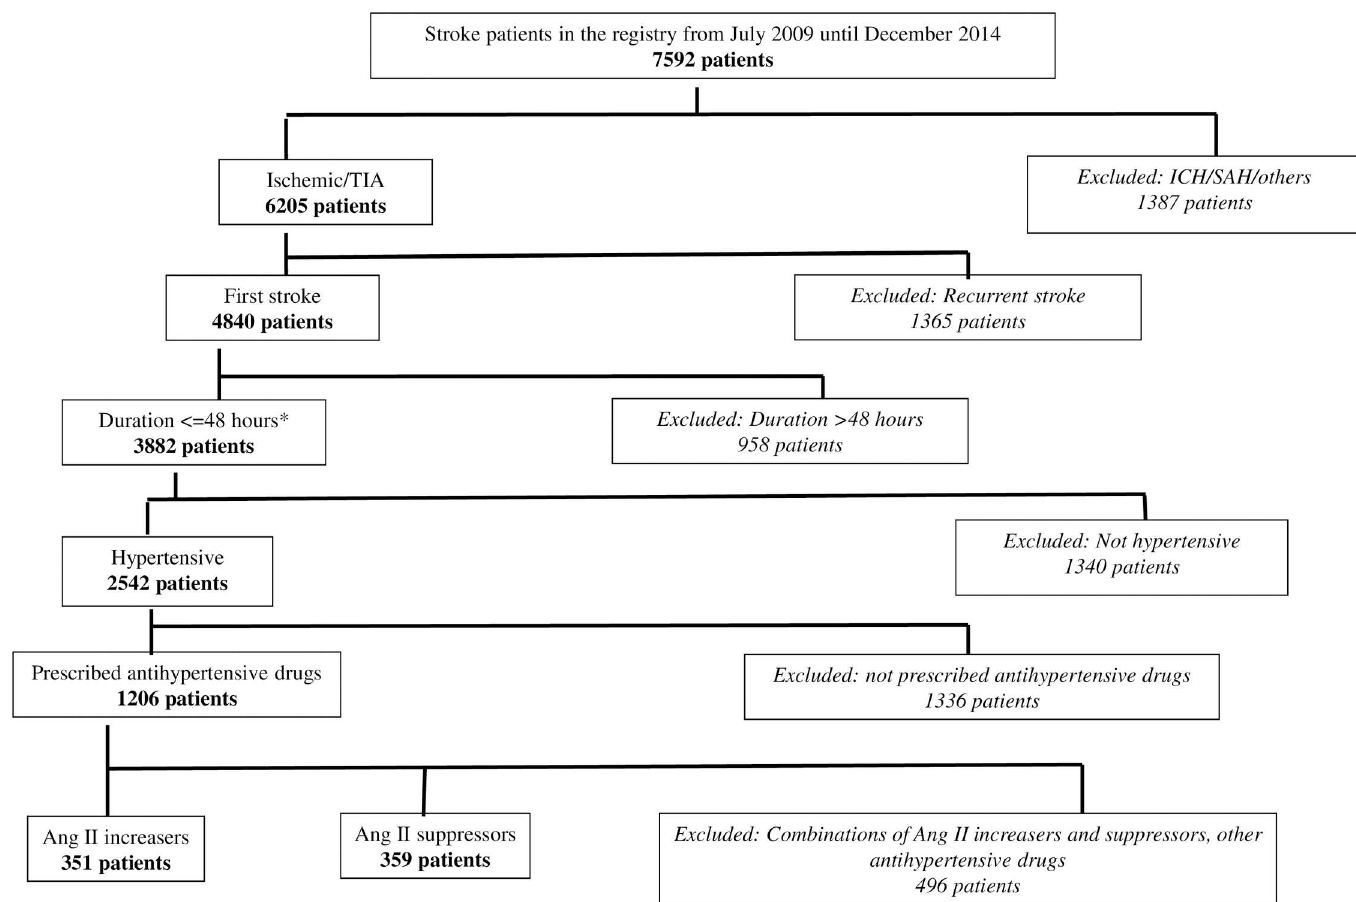
Fig 1. Flowchart for inclusion of patients (n = 710). * durationfrom onset of stroke symptoms to hospital arrival, TIA: transient ischemicattack, ICH: intracranialhemorrhage, SAH: subarachnoid hemorrhage,Ang II: Angiotensin